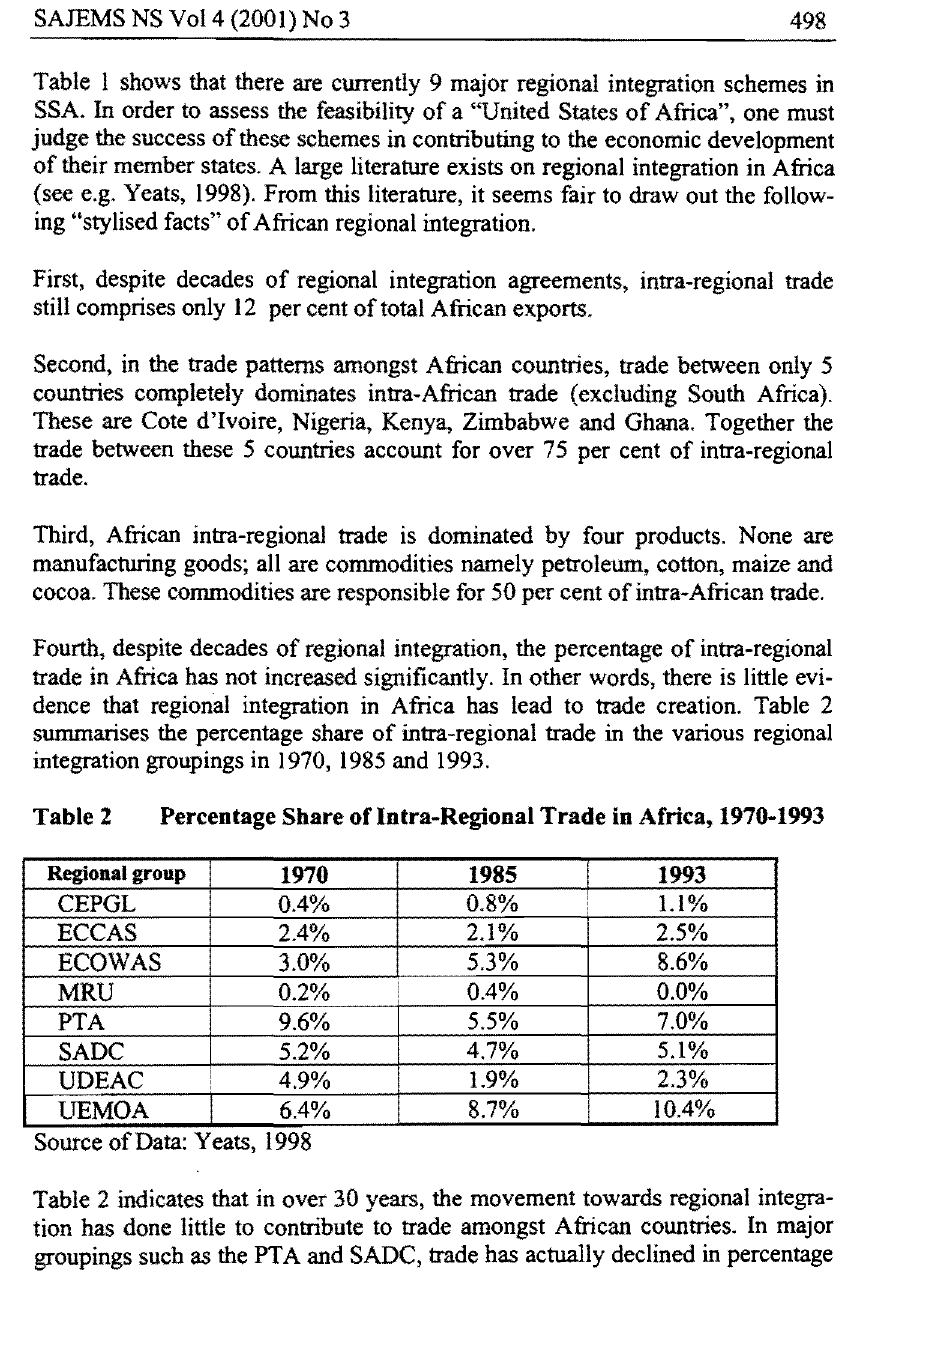
Percentage Share of Intra-Regional Trade in Africa, 1970-1993 Regional group 1970 1985 1993 CEPGL 0.4%